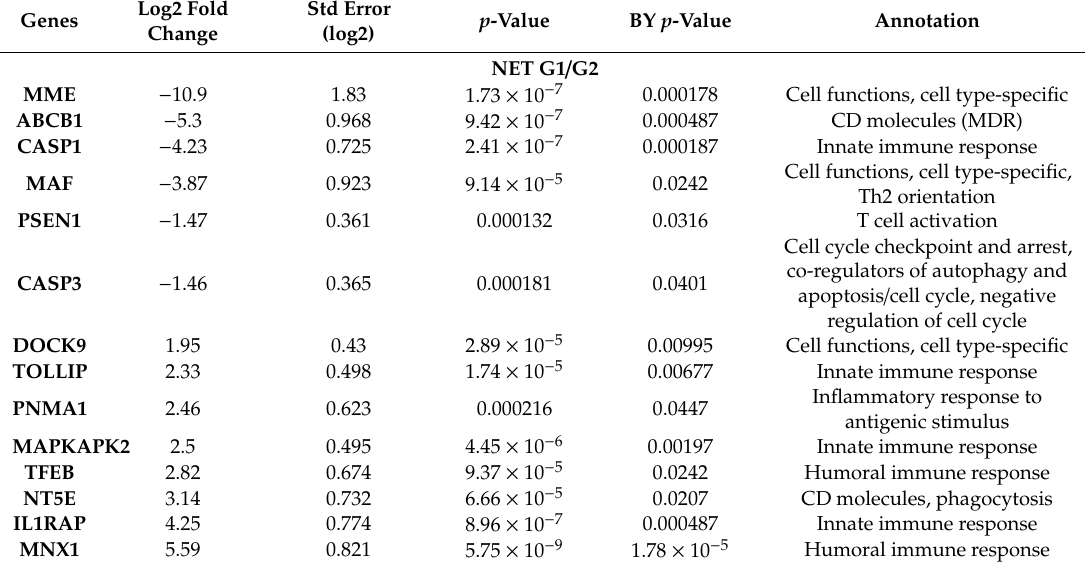
Table 3. Di ff erentially expressed genes compared to healthy ileal